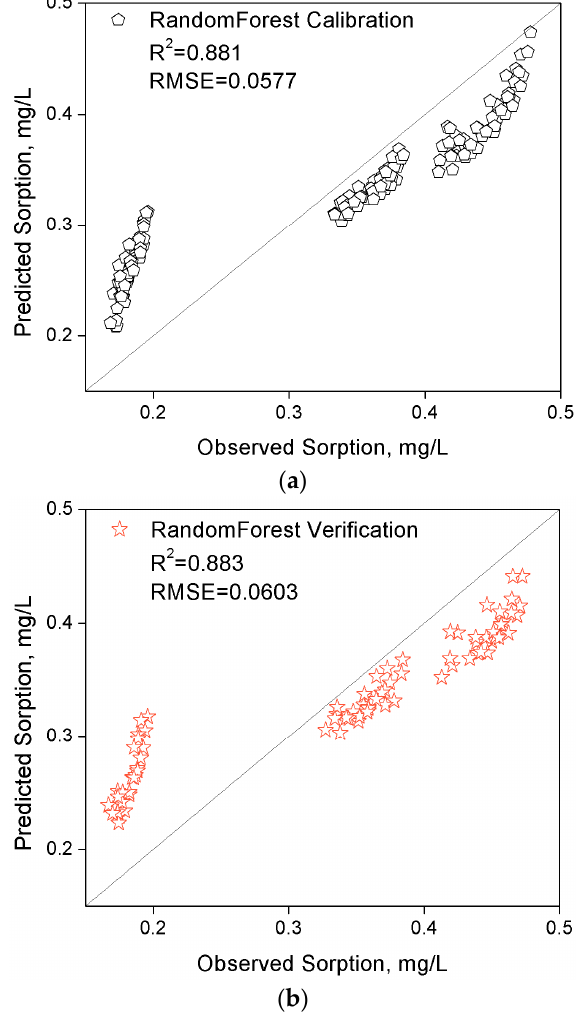
Figure 4. The calibration ( a ) and verification ( b ) of phenanthrene sorption data using the random forest (RF) method (Run No. 3).